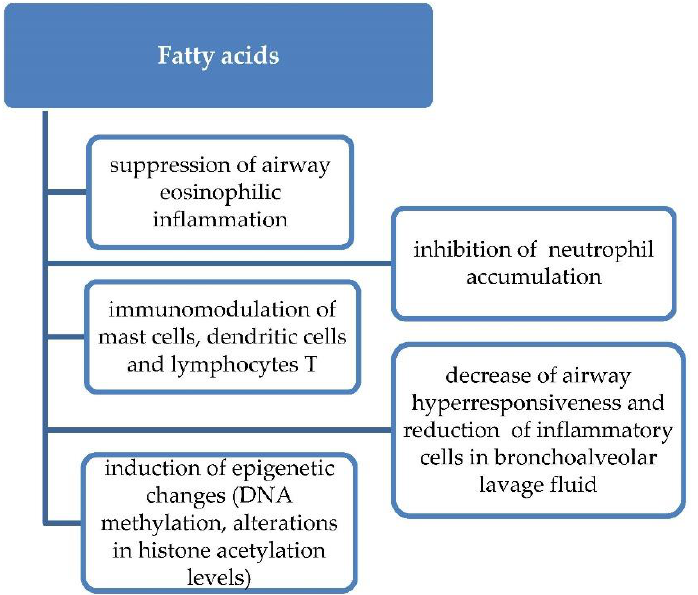
Figure 4. Proposed mechanism of action of fatty acids in asthma primary prevention.